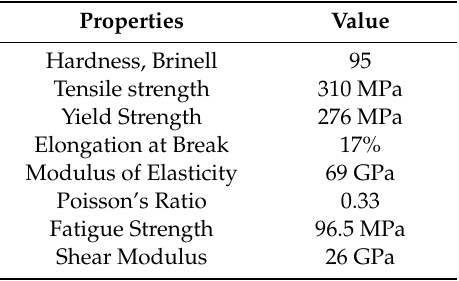
Table 3. Aluminum alloy Al6061properties.